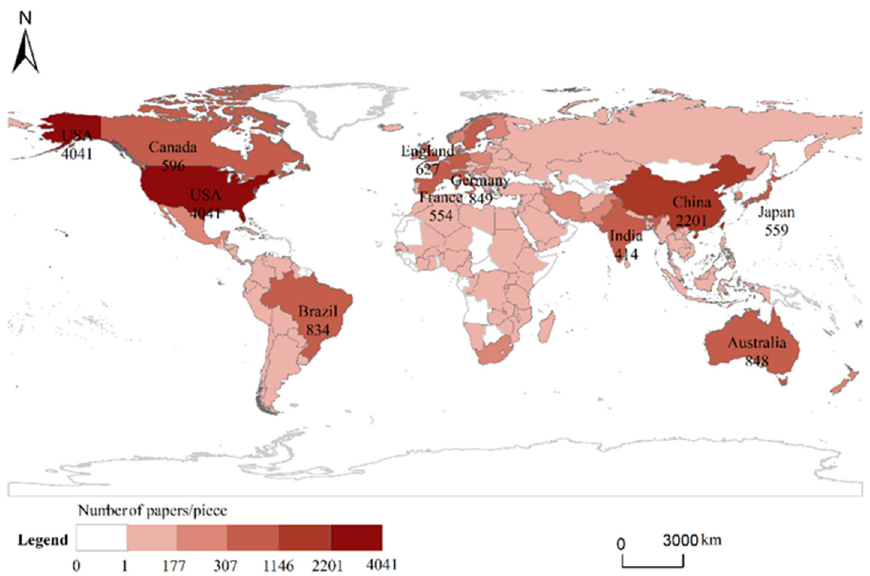
Figure 2. National distribution of crop–livestock system studies during the period 1981 ‒ 2021.